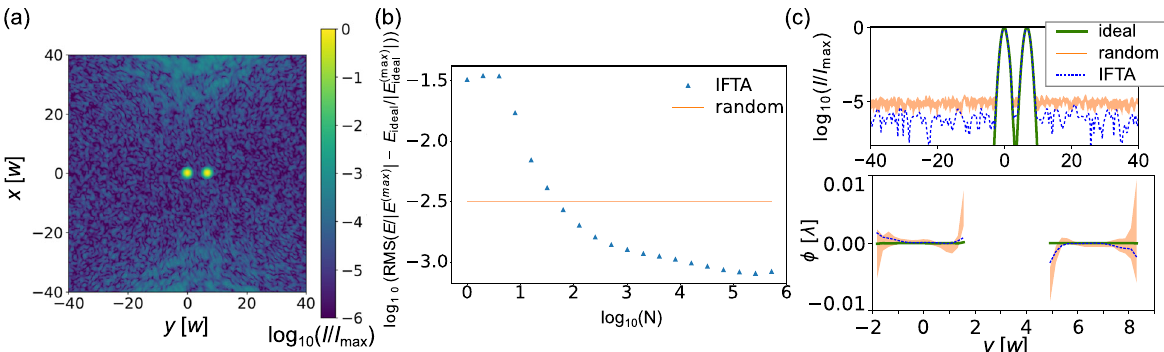
Fig. 5 Benchmarking IFTA against randomized algorithms. a The simulated intensity pro fi le at the image plane from the hologram generated by a randomized algorithm 38 with the same target pro fi le as in Fig. 4b. b Simulated electric fi eld RMS error compared to the target pro fi le E ideal within the signal window at the image plane versus the number of iterations N . c Cross-section of the simulated intensity and phase pro fi les along the ion chain direction ( y ), at x = 0. The phase is plotted for the regime that the intensity relative to the peak is larger than 10 − 3 . Here, we compare IFTA ( N = 2000 iterations) with a randomized algorithm and with the ideal target pro fi le. The lower and upper bound of the shaded areas in b and c indicate the fi rst and third quantities from 20 simulations with the randomized